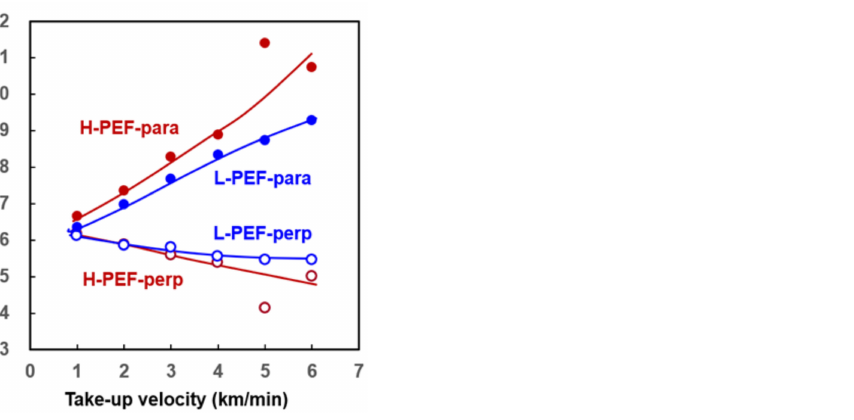
Figure 3. Variation of refractive indices in the directions parallel and perpendicular to the fiber axis with take-up velocity for high-speed spun L-PEF and H-PEF